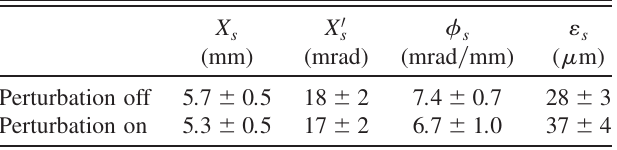
TABLE III. Beam parameters for the rectangular beam, mea- sured from phase-space tomography at LC1. The subscript s indicates that those measurements are conducted at the screen in LC1 ( z ¼ 43 cm ).